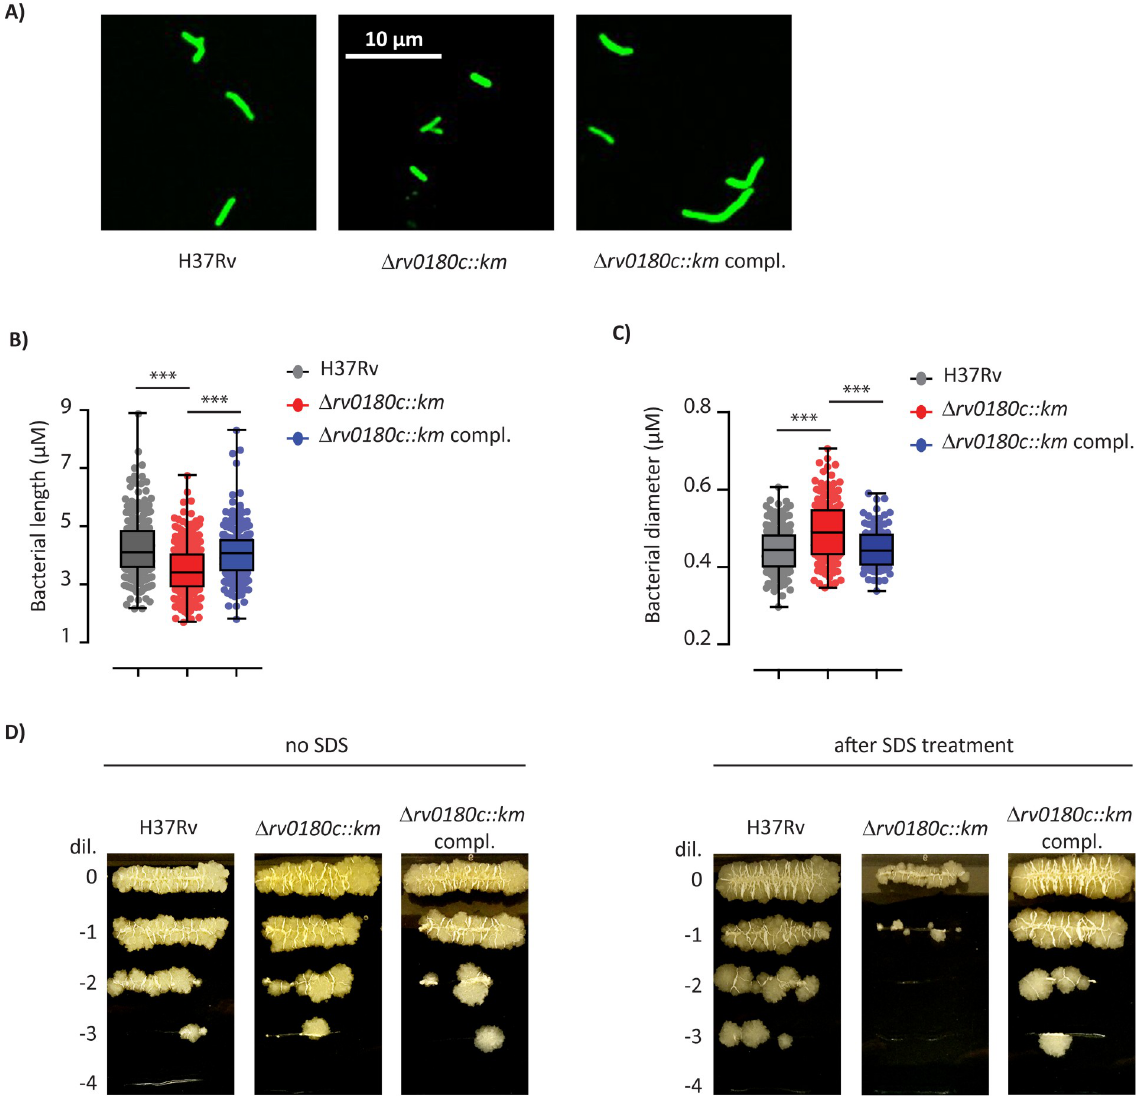
Fig 7. The Δ rv0180c :: km mutation impacts the bacterial cell shape and cell envelope function. (A) Fluorescence microscopy image of H37Rv (WT), the Δ rv0180c :: km mutant, and the Δ rv0180c :: km complemented strains grown for 10 days in 7H9 ADC liquid medium. (B) Distribution of bacterial length for the parental H37Rv, the Δ rv0180c :: km mutant and the Δ rv0180c :: km complemented strains. Between 140 and 220 bacterial cells from two experiments were analyzed. (C) Distribution of bacterial diameter for the parental H37Rv, the Δ rv0180c :: km mutant and the Δ rv0180c :: km complemented strains. Around 80 bacterial cells from two independent experiments were analyzed. For (B) and (C), the statistical significance was evaluated using the Kruskal-Wallis rank sum test followed by Dunn’s multiple comparison test: ��� p < 0.001. (D) Impact of incubation with detergent on the viability of H37Rv, the Δ rv0180c :: km mutant, and the Δ rv0180c :: km complemented strains. Bacteria grown in 7H9 ADC to exponential phase (OD 600nm between 0.6 and 0.8) were incubated with or without 0.1% SDS during 4 days before spotting 5 μ l of serial dilution on 7H11 OADC agar